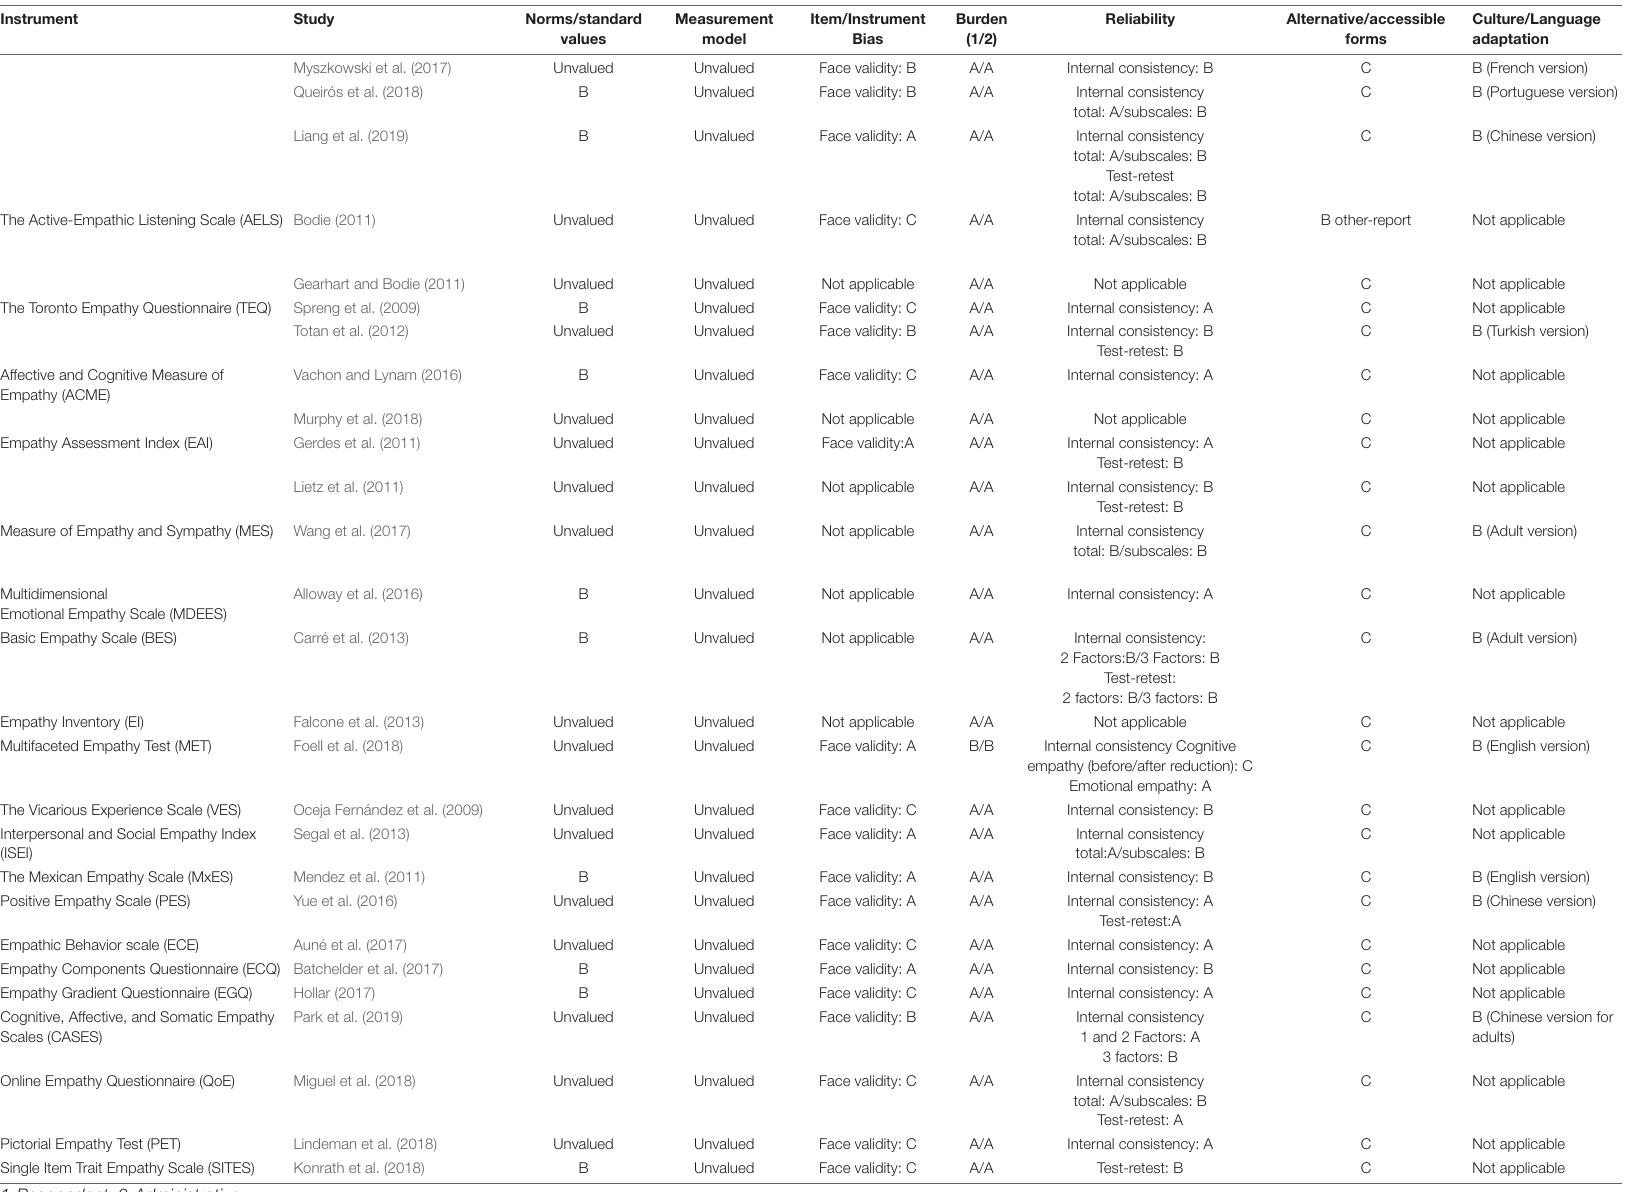
C B (Chinese version for 1 and 2 Factors: A adults) 3 factors: B C Not applicable total: A/subscales: B Test-retest: A